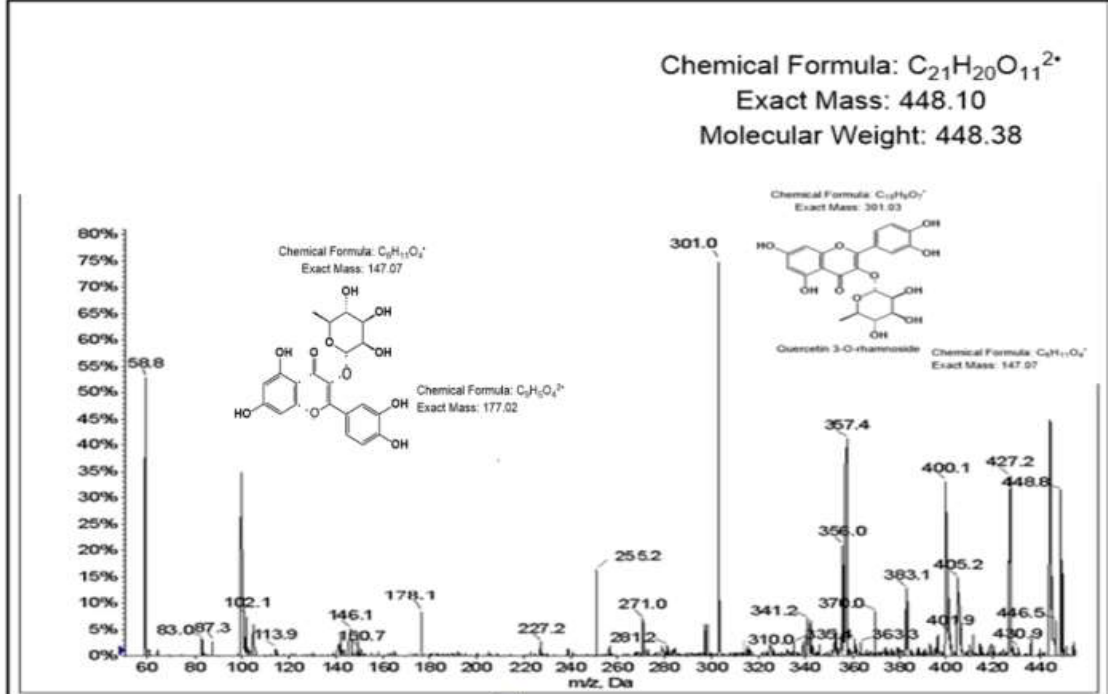
Figure 8. LC/MS-MS Spectra of isolated quercetin